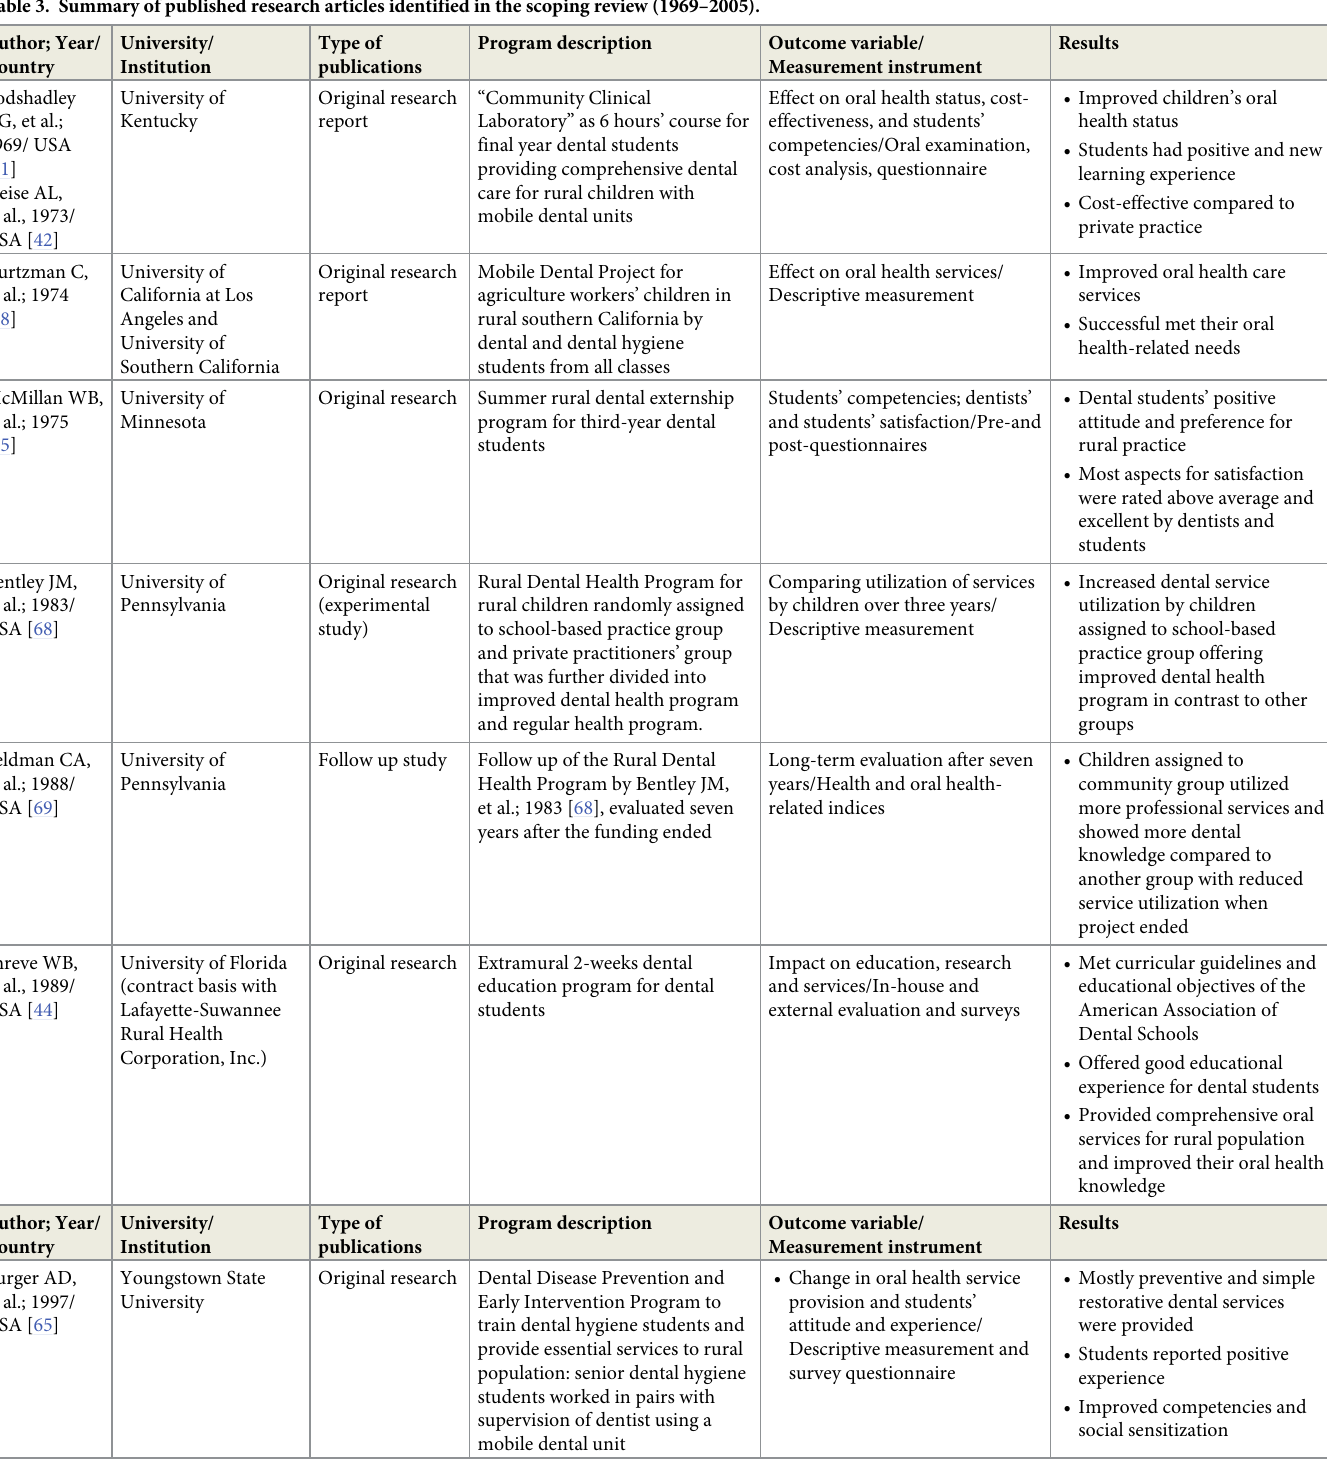
Table 3. Summary of published research articles identified in the scoping review